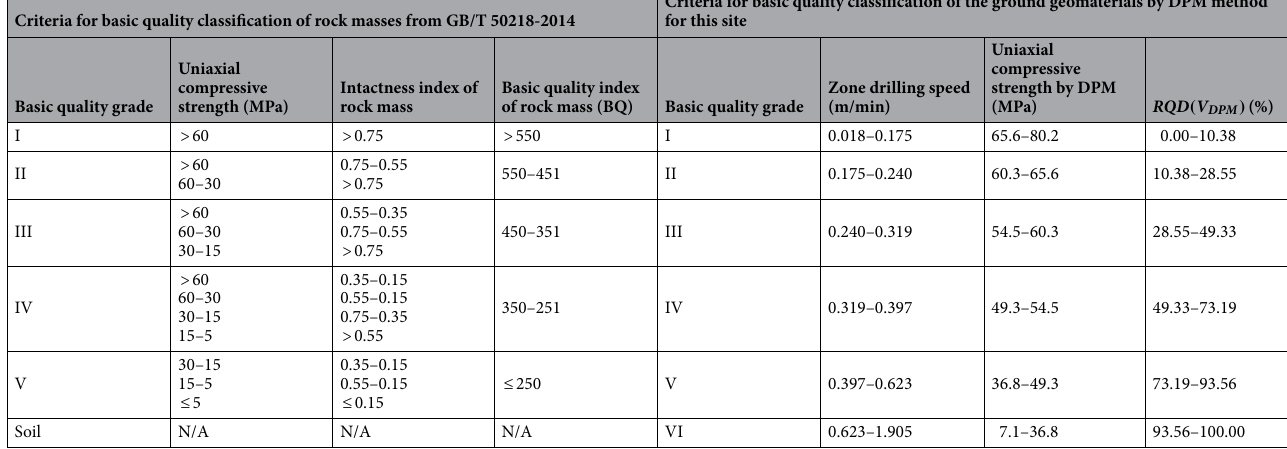
Table 2. Criteria for basic strength quality classification of rock masses or ground geomaterials from the standard GB/T 50218-2014 and digitalization method.